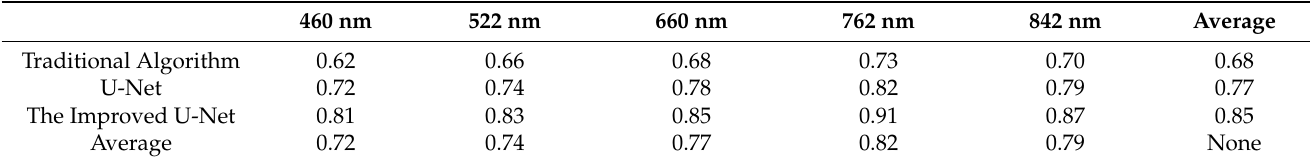
Table 2. mIoU of the traditional algorithm, U-Net, and improved U-Net.